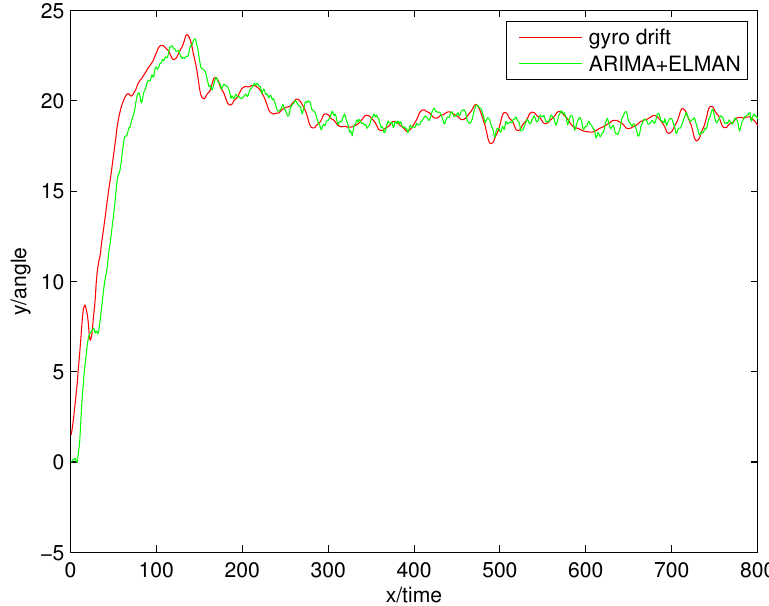
Figure 12. Compensation results based on the ARIMA-Elman method.